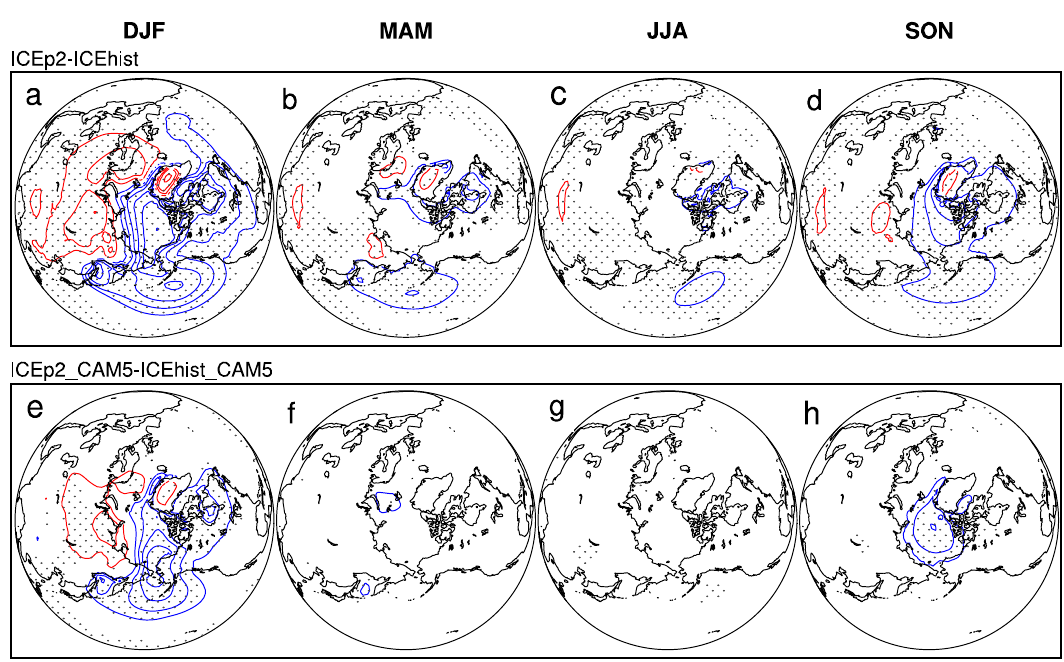
sea ice during 2080 – 2099 (ICEp2_CAM5) and during 1980 – 1999 (ICEhist_CAM5). The contour interval is 1-hPa, and statistically signi fi cant (>95% con fi dence level) values are marked by gray